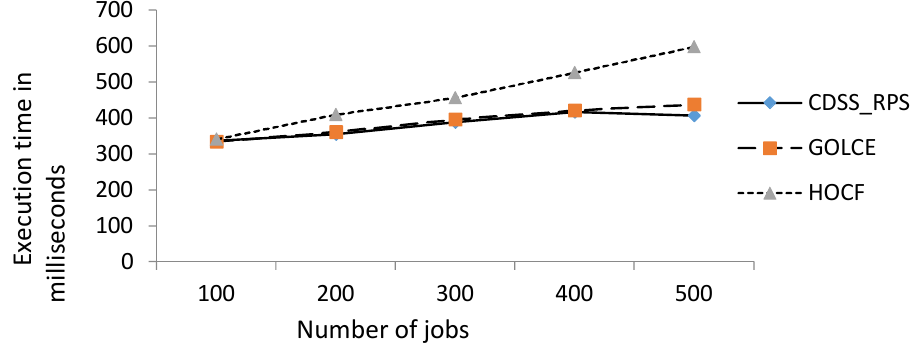
Figure 7. Execution time for all sets of jobs.